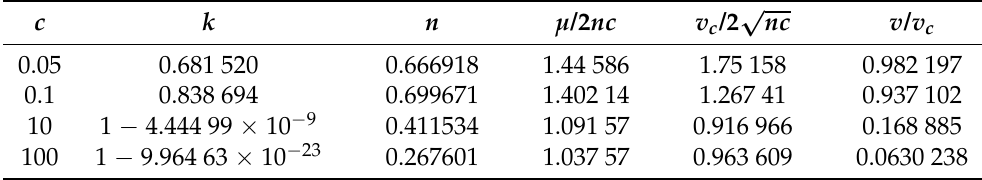
Figure 11. Phase profiles arg [ ψ Q ( x )] / π for the matrix elements (89) (red solid curves) and their classical counterparts (blue broken curves) for coupling constants c = 0.05, 0.1, 10, and 100. The parameters of the elliptic solutions are shown in Table 4. In the all panels, the red solid curves completely agree with the blue broken curves. Table 4. Parameters of the elliptic solutions for Figures 10 and